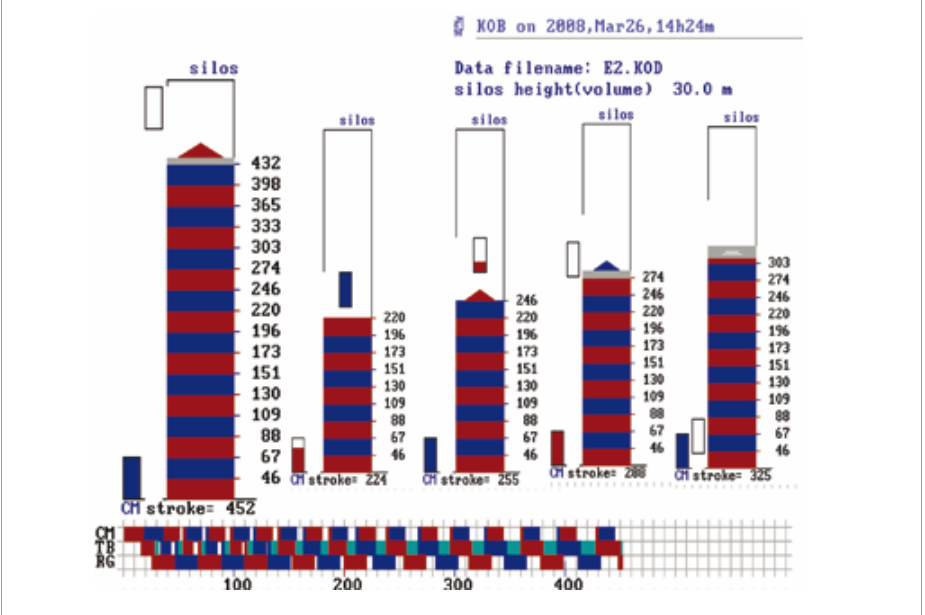
Fig. 5. Dynamic visualisation – 5 characteristic phases of the